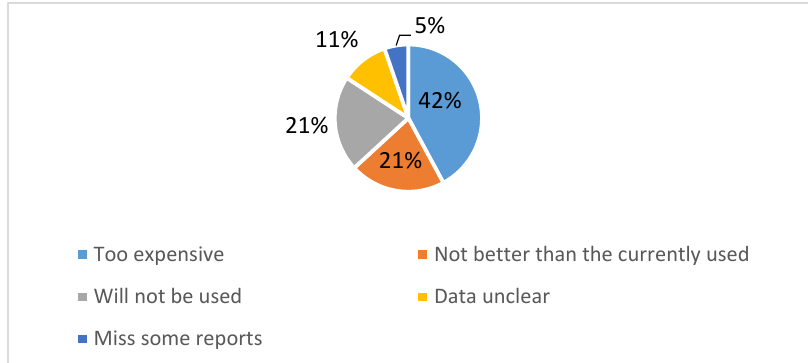
Figure 9. The disadvantages of the current FMIS.